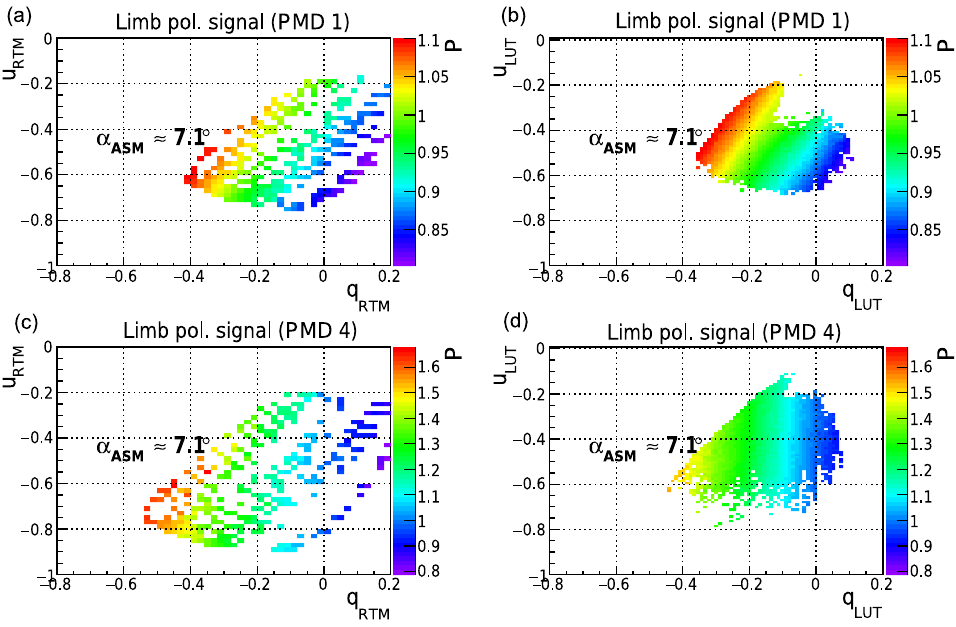
Figure 6. Polarization signals for limb (rainbow color code) in 2004 vs. q RTM ( LUT ) ( x axis) and u RTM ( LUT ) ( y axis), TH ≈ 28km, from the extrapolation method (a, c) and the LUT method (b, d) for PMD 1 (a, b) , PMD 4 (c, d) and for an ASM mirror angle of about + 7 ◦